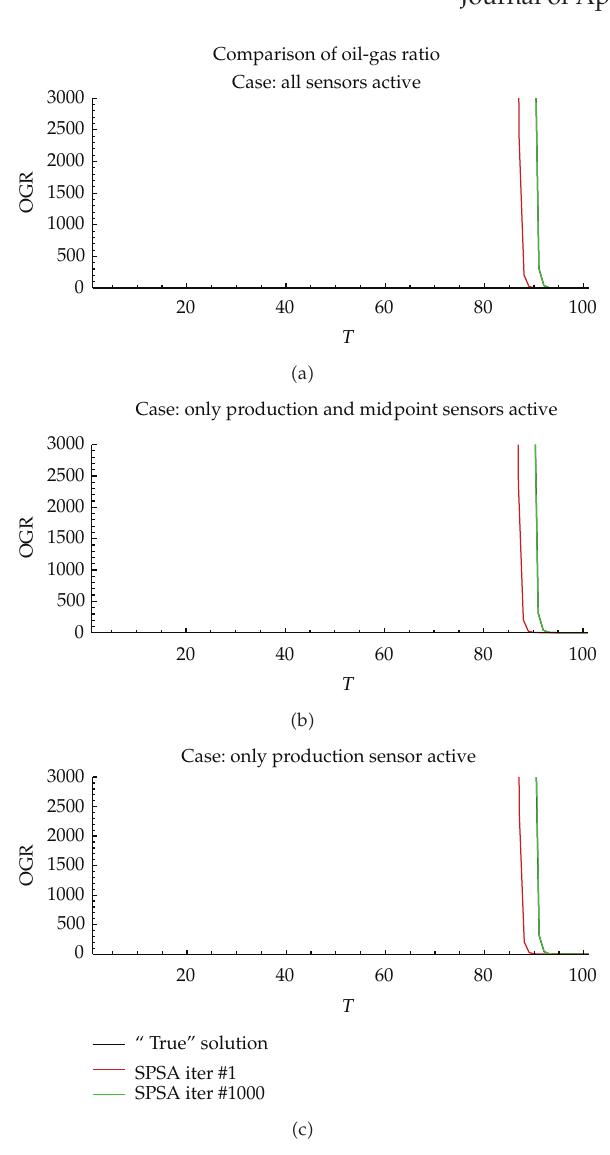
Figure 6: Example 1: history matching of well-data based on sensor